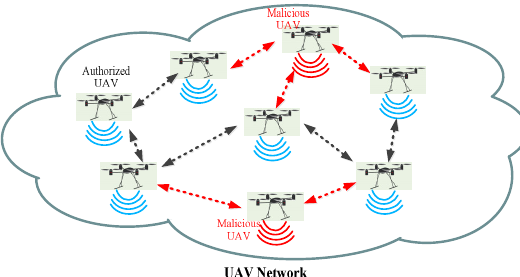
Figure 1. A malicious eavesdropping scenario where malicious unmanned aerial vehicles (UAV) attack authorized UAVs through the UAV network.